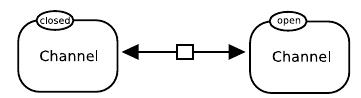
Figure 2.29: Reversible opening and closing of an ionic channel.